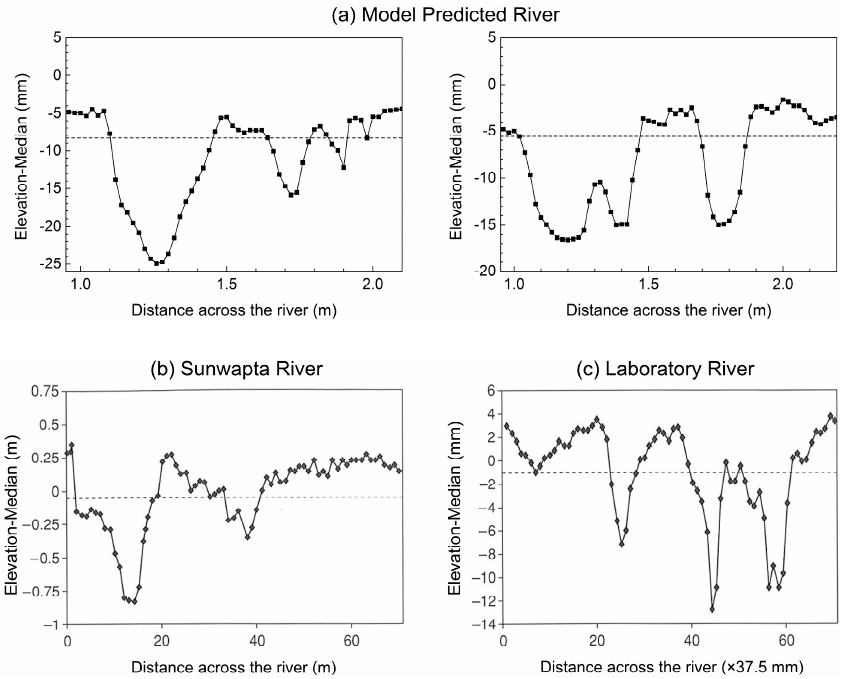
Figure 11 . Deviations from the elevation median of cross-sections for ( a ) the model predicted river; ( b ) the Sunwapta River; and ( c ) a laboratory river. The dotted line represents the elevation median.